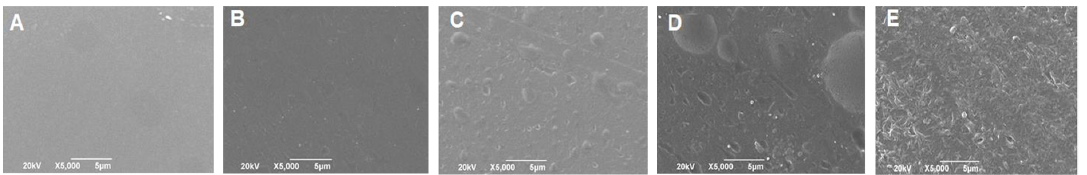
Figure 5. Morphology of CS/PVA/GO films. ( A ) F1: CS/PVA/GO 20:80:0; ( B ) F2: CS/PVA/GO